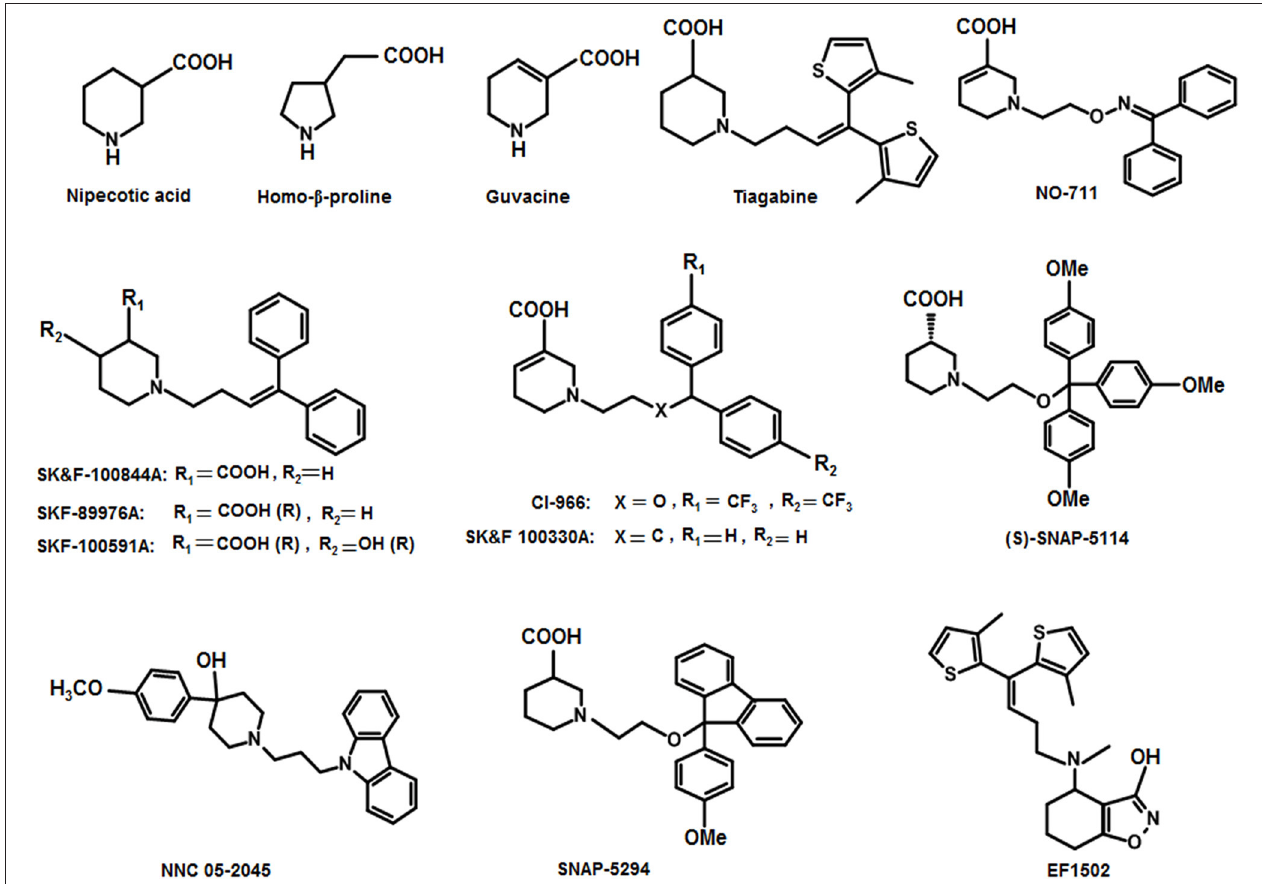
FIGURE 9 | Chemical structures of well-known GAT